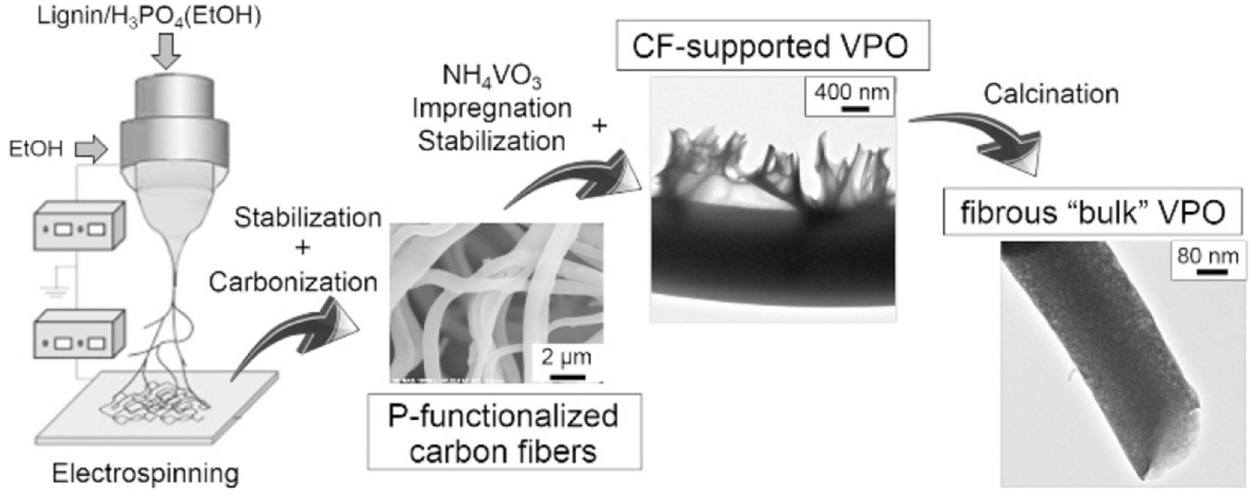
Scheme 1. Synthesis procedure for VPO/CNFs and fibrous VPO catalytic materials. Reproduced